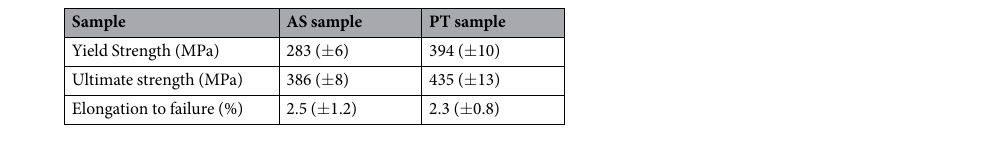
Table 1. Yield strengths, ultimate strengths and elongations of the peak aged samples under tension along the ED. The numbers shown in parentheses are standard deviations obtained from repeated